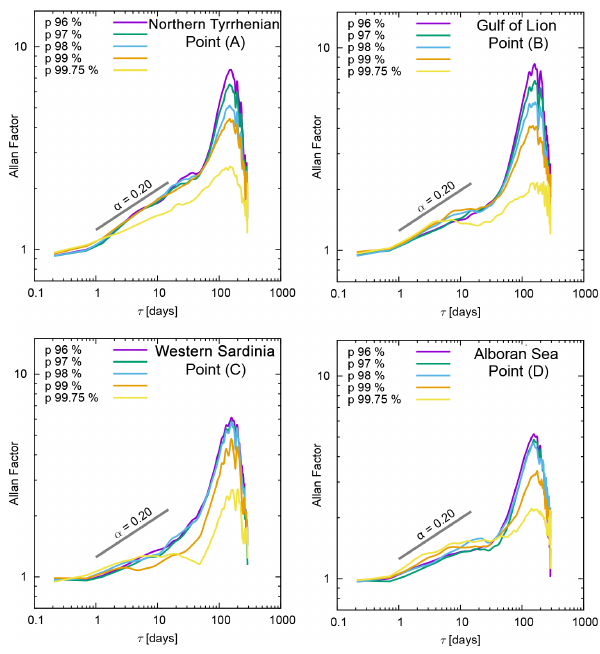
Figure 8. Allan factor (AF) as a function of counting window τ and of the wave height threshold (different percentiles as in the legend) for different locations in the Mediterranean Sea (cf. Fig. 2).